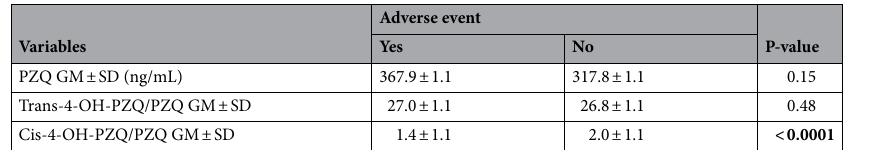
Table 5. Comparison of the geometric means of PZQ, (ng/mL) and metabolic ratio (trans-4-OH-PZQ/ PZQ and cis-4-OH-PZQ/PZQ) among those that experienced adverse events and those that did not. PZQ Praziquantel, SD standard deviation. Significant values are in